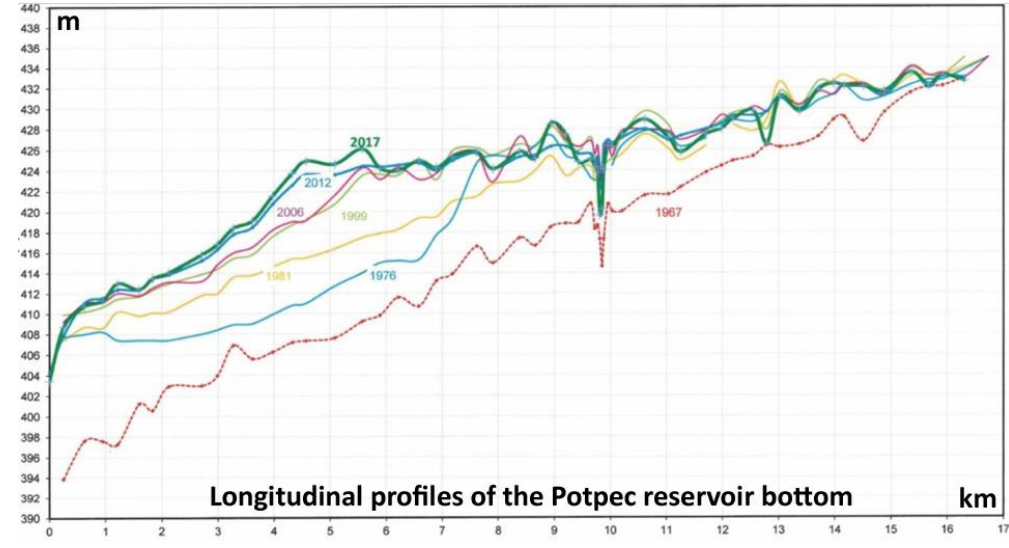
Figure 19. Longitudinal profiles of the Potpec reservoir bottom surveyed in di ff erent